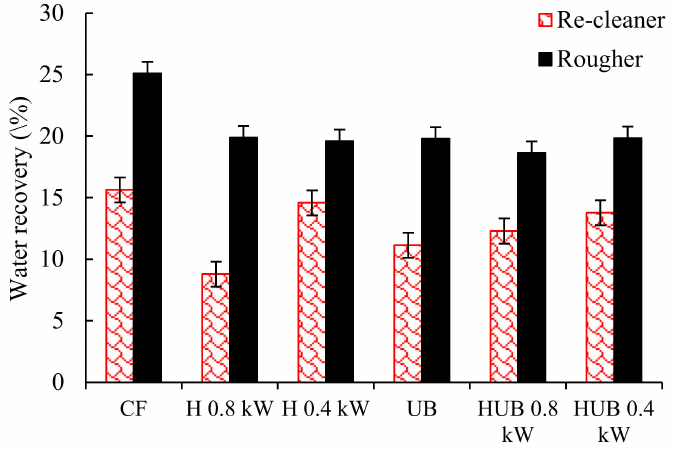
Figure 7. Water recovery to concentrate for both the rougher and re-cleaner